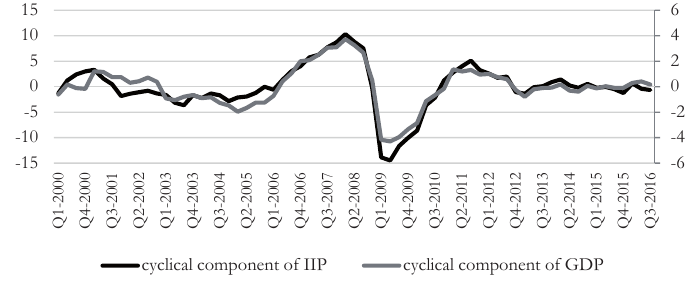
Fig. 1 – Development of the cyclical component of GDP and the cyclical component of IPP, 2000 – 2016. Source: Own